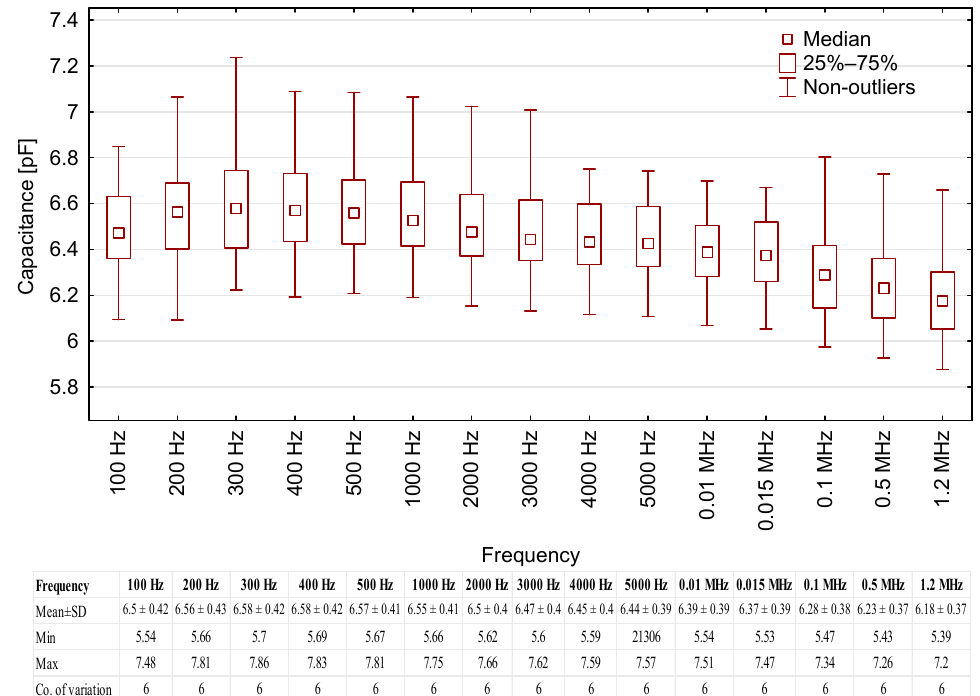
The capacitance of the motor oils in the test system was also measured. The correla- tion between mean capacitance and the frequency of test voltage is presented in Figure 6.